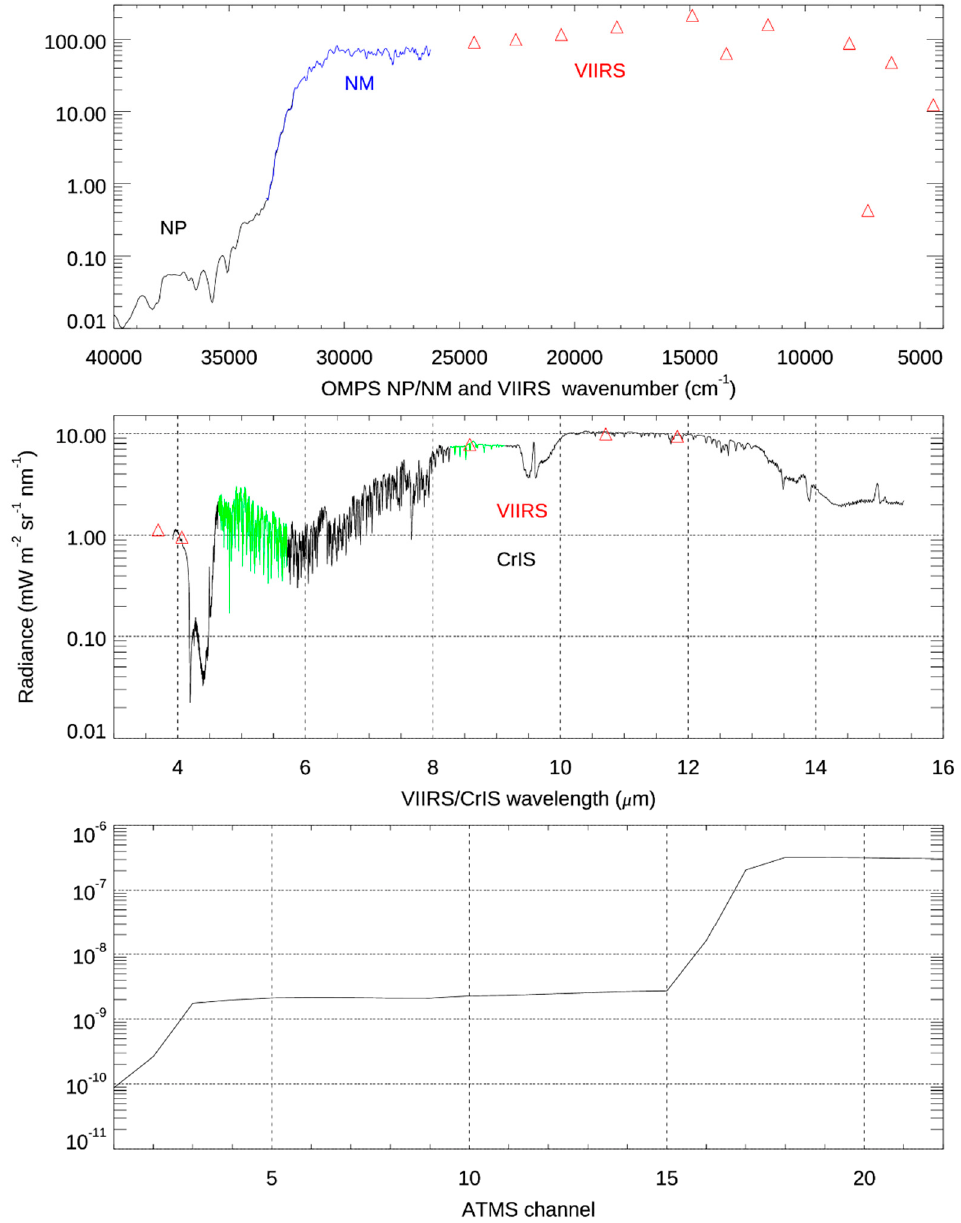
Figure 1. SNPP OMPS Nadir Mapper and Nadir Profiler radiances ( top ), VIIRS and CrIS radiance ( middle ), and ATMS radiance ( bottom ) over the Libya I desert site on 2 March 2021.